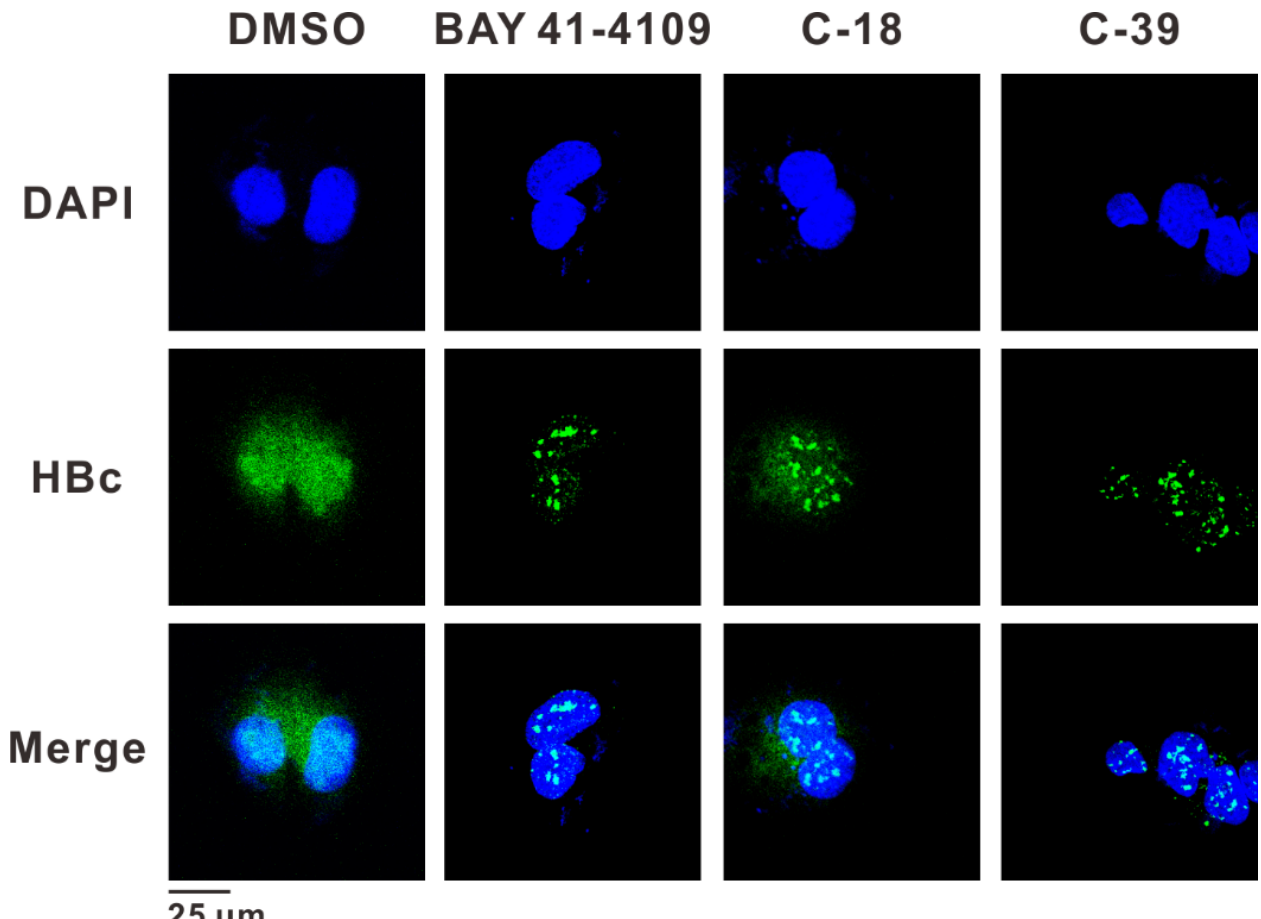
Figure 7. Effects of C-39 on the HBc aggregation. Confocal immunofluorescence microscopy images showing HBV core protein (in green) distribution in HepAD38 cells after 3 days of incubation of DMSO, BAY 41-4109 (2 μM), C-18 (5 μM), and C-39 (5 μM). Nuclei are DAPI stained (blue). Scale bar: 25 μm.